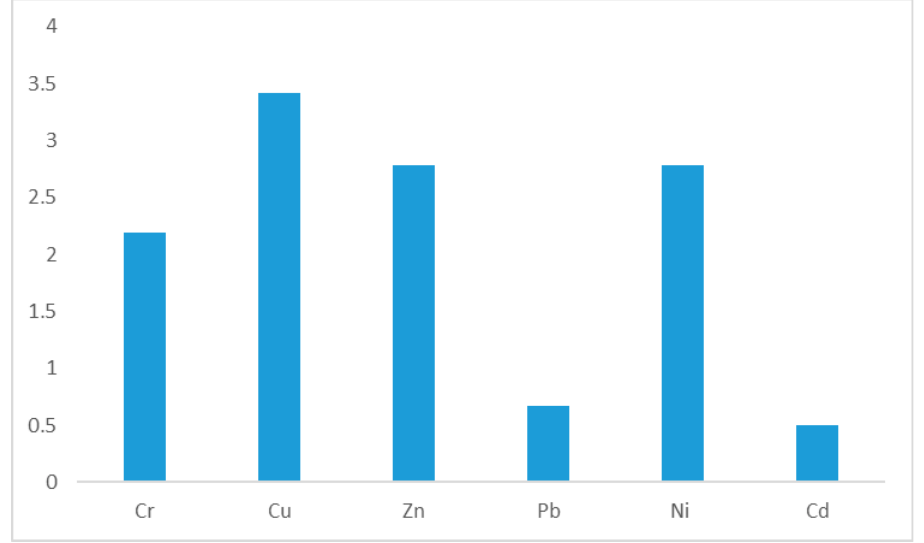
Figure 2. Representation of the pollution index values of the study sites.